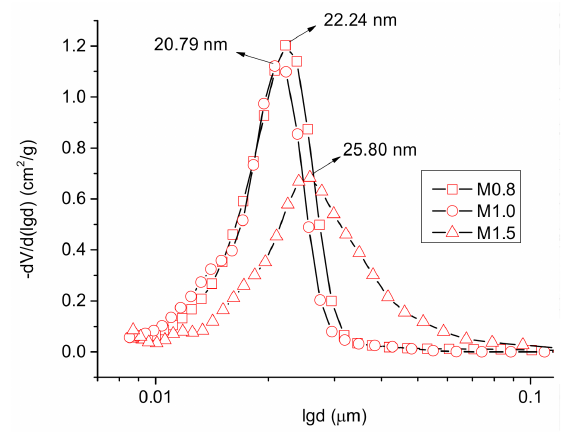
Figure 17. Pore size distribution of the geopolymer